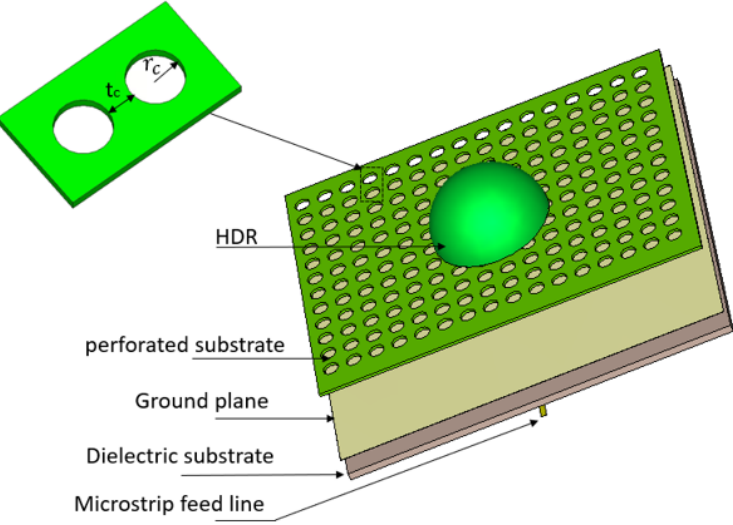
Figure 17. Geometry of the integrated hemispherical DRA and perforated top substrate.